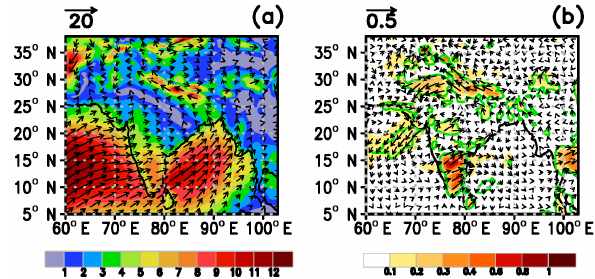
Figure 5. Seasonal (JJAS)-averaged wind at 10m (in ms − 1 ; 1982– 2008). (a) Climatological mean (PLC experiment) and (b) differ- ence (PLC–HLC). The shaded color depicts magnitude and arrows show the direction. Green contour shows differences significant at the 90% confidence